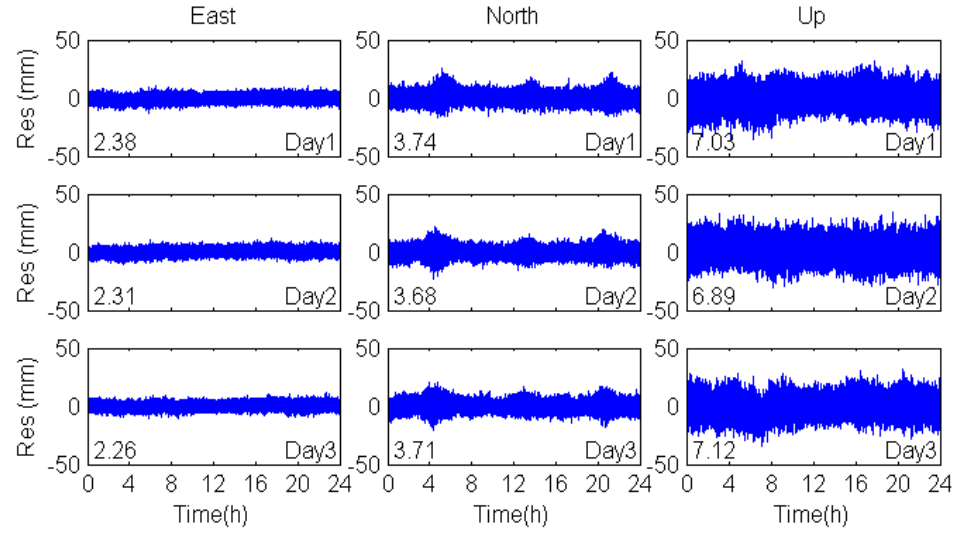
Figure 10. MHM model filtering results for multipath errors in the east, north and vertical coordinate directions.